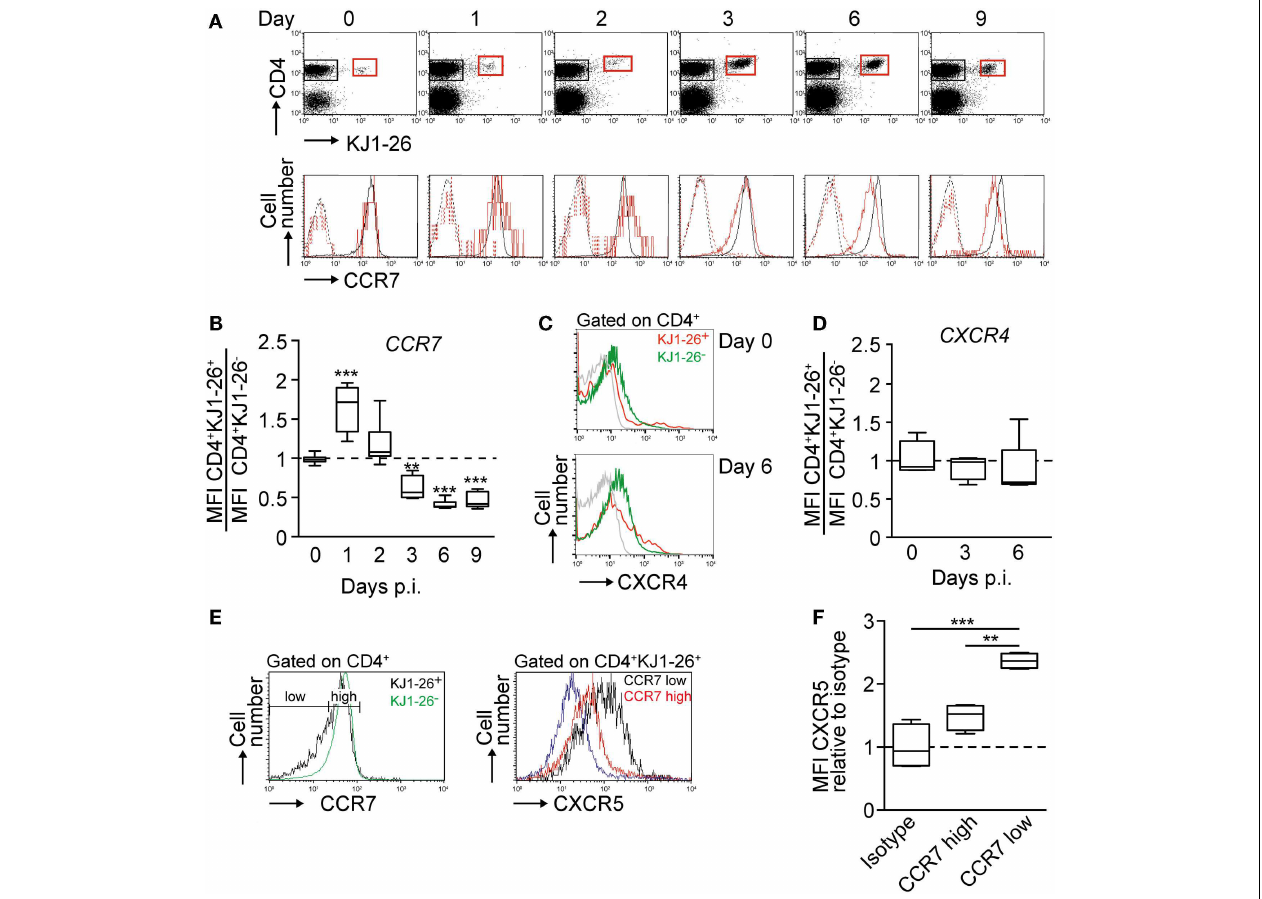
CD4 + T cells after OVA/CFA immunization. (E) Left panel. Gating strategy for CCR7 low and CCR7 high CD4 + KJ1–26 + T cells on day 5 post OVA/CFA immunization. CCR7 levels on endogenous CD4 + KJ1–26 (cid:0) T cells are depicted in green. Right panel. CXCR5 expression levels on CCR7 low (black) and CCR7 high (red) CD4 + KJ1–26 + T cells. The isotype control is shown in blue. (F) Ratio of CXCR5 MFI on CCR7 low and CCR7 high KJ1–26 + CD4 + T cells on days 5/6 after OVA/CFA immunization, normalized to isotype control. Data are pooled from 2–5 independent experiments combining 4–10 mice/time point. Data in (B,D,F) were analyzed using ANOVA and Dunnett’s (B,D) or Tukey’s (F) multiple comparison test and are shown as box and whiskers graphs. ** p < 0.01; *** p <